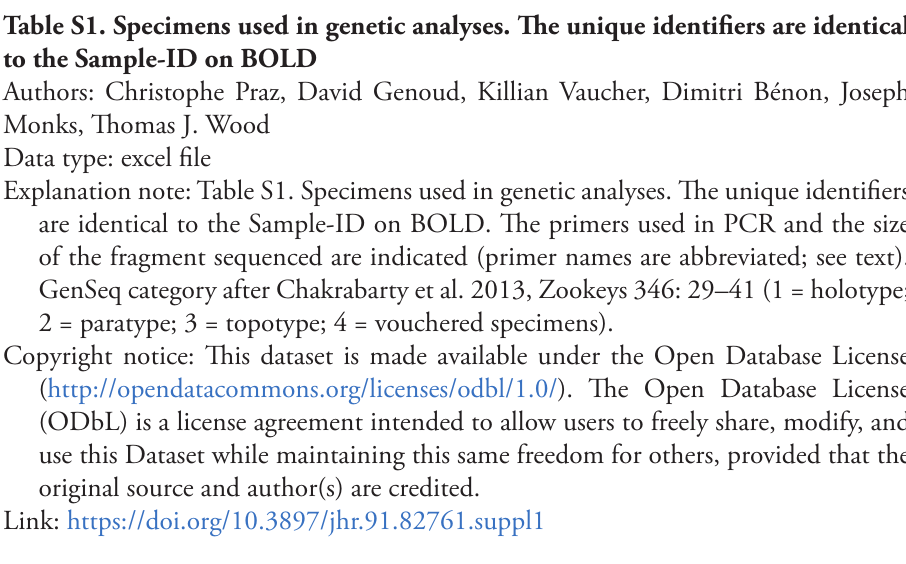
Table S1. Specimens used in genetic analyses. The unique identifiers are identical to the Sample-ID on BOLD